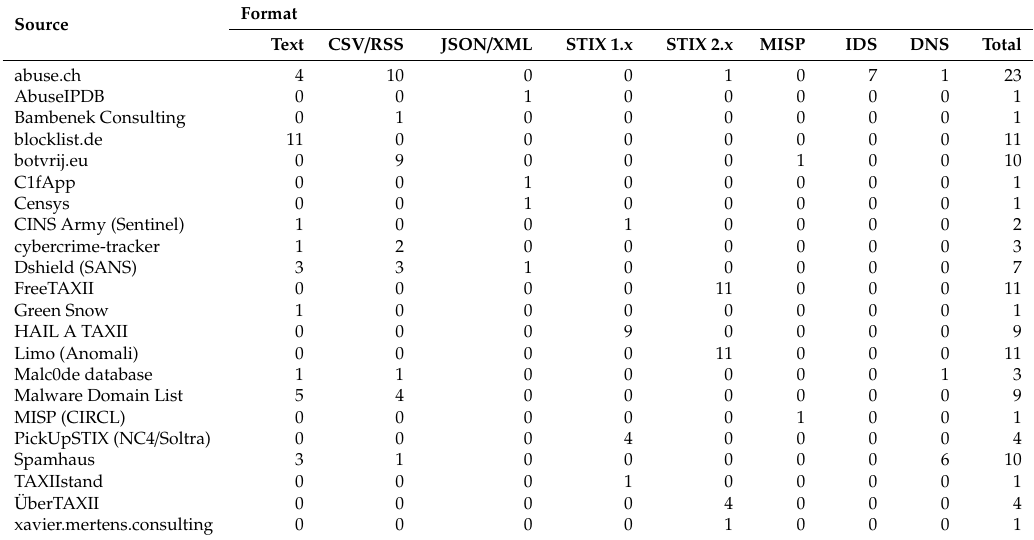
Table 2. CTI Sources’ Formats